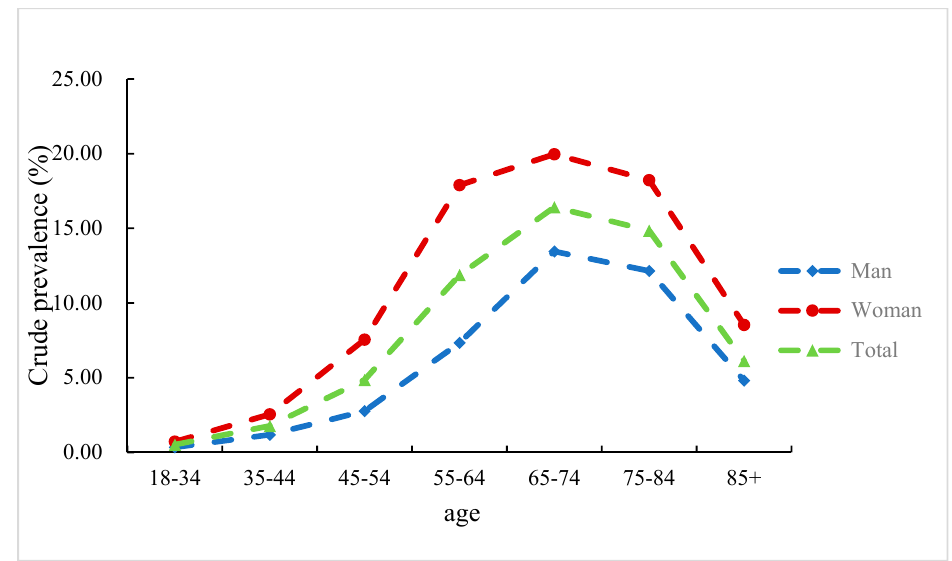
Figure 1. Average crude prevalence of knee osteoarthritis for all age groups in Beijing, China, 2008–2017 (%).